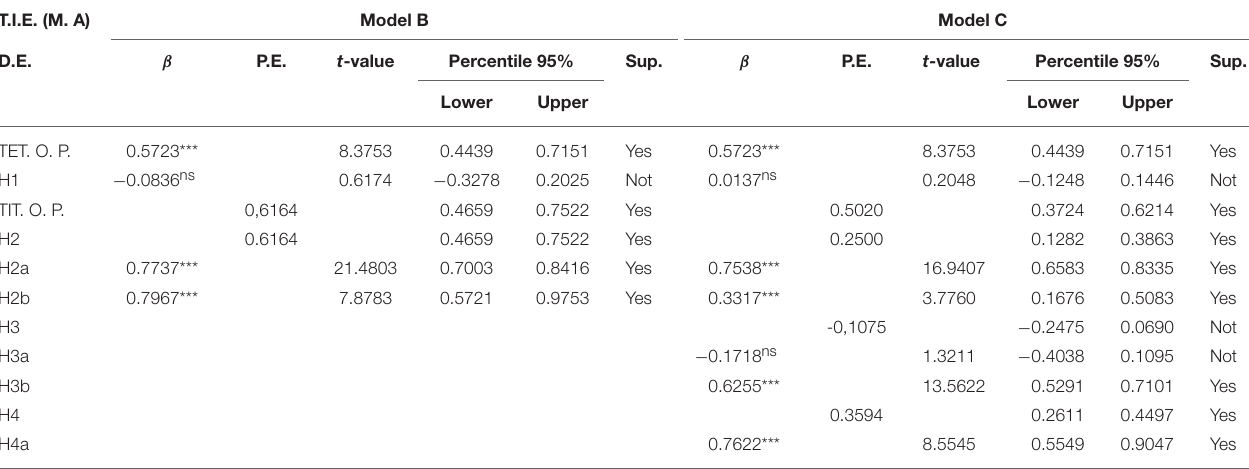
TABLE 5 | Structural equation models